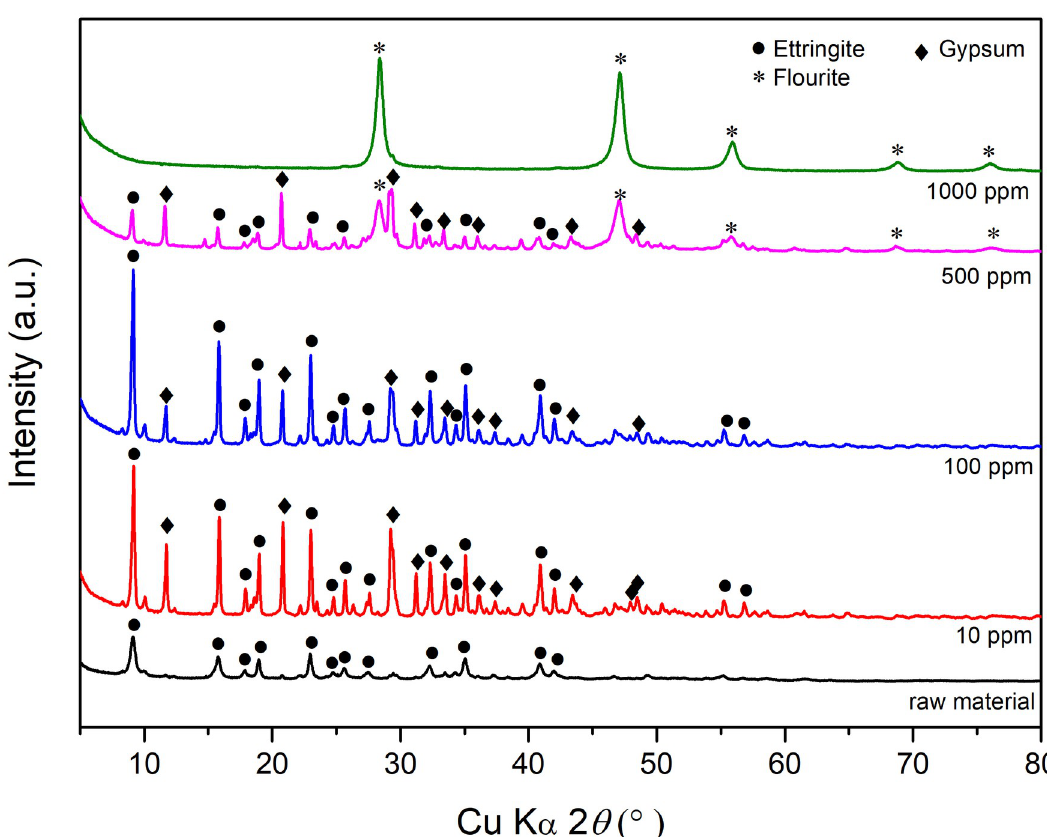
Fig 9. XRD patterns of metaettringite before and after fluoride removal with different initial fluoride concentration; symbol ● (ettringite, PDF No. 00-037-1776), � (fluorite, PDF No. 01-070-2782), ◆ (gypsum, PDF 00-006-0047).